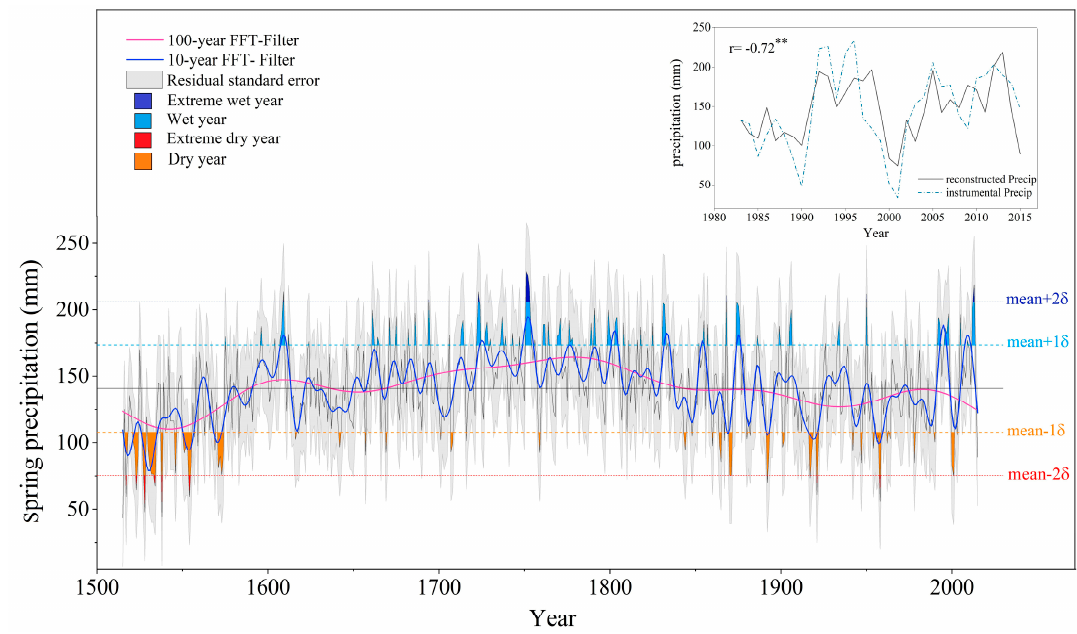
Figure 4. Reconstruction of spring precipitation py AMJ + AMJ for the southern slope of the Alborz Mountains during the period 1515–2015. Blue and red lines represent decadal and centennial δ 18 O variations calculated with 10 and 100-year FFT-Filters, respectively. The horizontal black and dotted colored lines indicate the 501-year mean and dry / wet and extreme dry / wet events, respectively, based on the dryness / wetness classification by Liu et al. [65]. Inlay rectangle: comparison between the reconstructed and instrumental precipitation variations during the calibration period of 1983–2015.